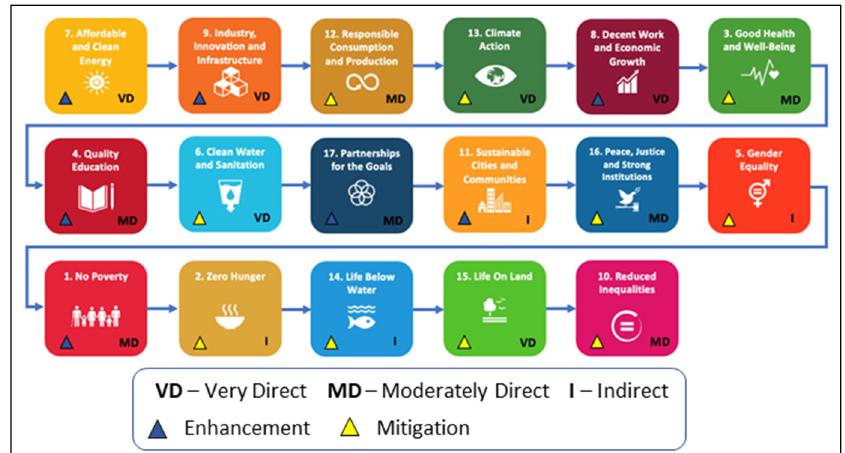
Figure 1. Ranking of the significance of SDGs for the RM sector by the Greek stakeholder groups. The type of RM sector impact on the specific SDGs was codified based on EBRD [18].